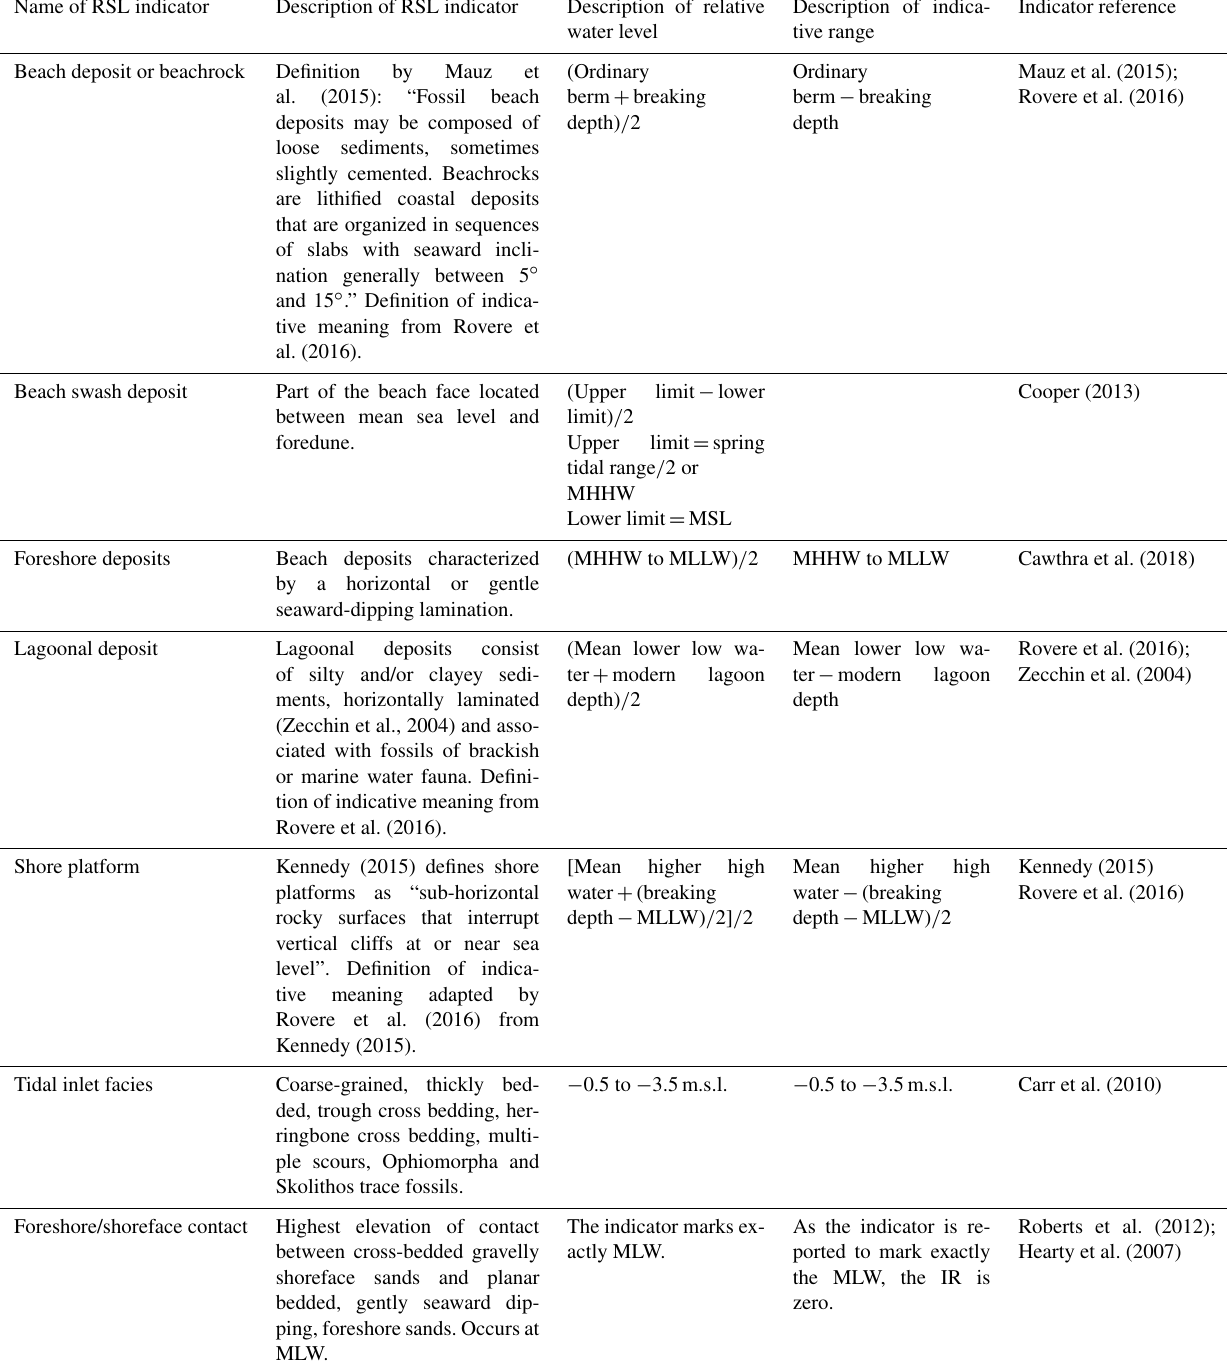
Table 1. Sea-level indicators used in this study and their relationship to sea level at the time of deposition. MHHW: mean higher high water; MLLW: mean lower low water (chart datum); MLW: mean low